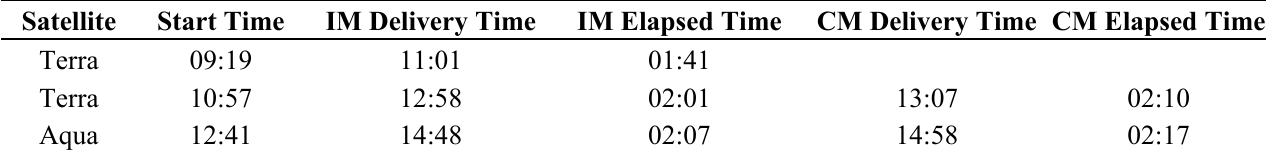
Table 1. Acquisition and delivery time for EURAC SCA products (IM and CM) respectively for the day 28 February 2011. On this day, two Terra and one Aqua overpasses were acquired by EURAC receiving